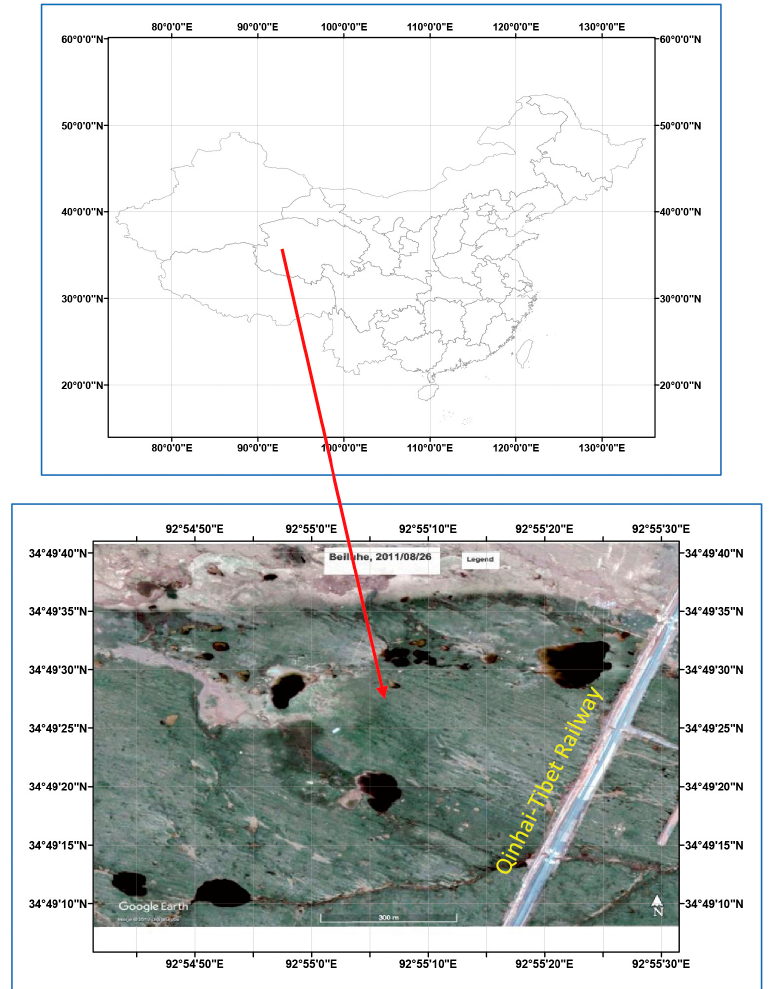
Figure 1. The locations of the monitored representative thermokarst lakes in the Beiluhe Basin on the Qinghai–Tibetan